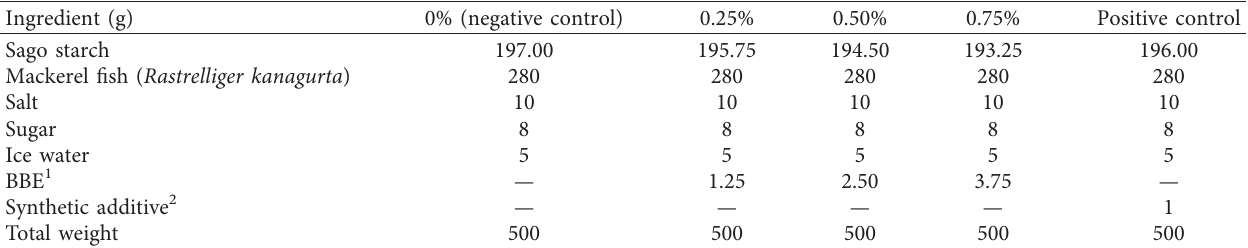
Table 1: Formulation of fish sausages incorporated with BBE at different concentrations and with synthetic additives. Ingredient